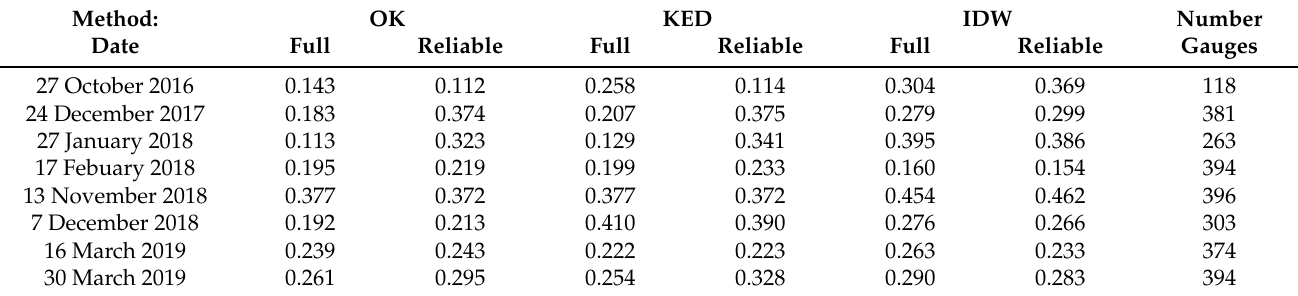
Table 1. Correlation (Kendall’s τ ) in Israel. Correlations between CML-derived rainfall and gauge observations, using Ordinary Kriging, Kriging with External Drift and Inverse Distance Weighted are presented. Both the Full set of CML and Reliable (outliers removed) set are presented for each interpolation method, as well as the number of gauges used for each